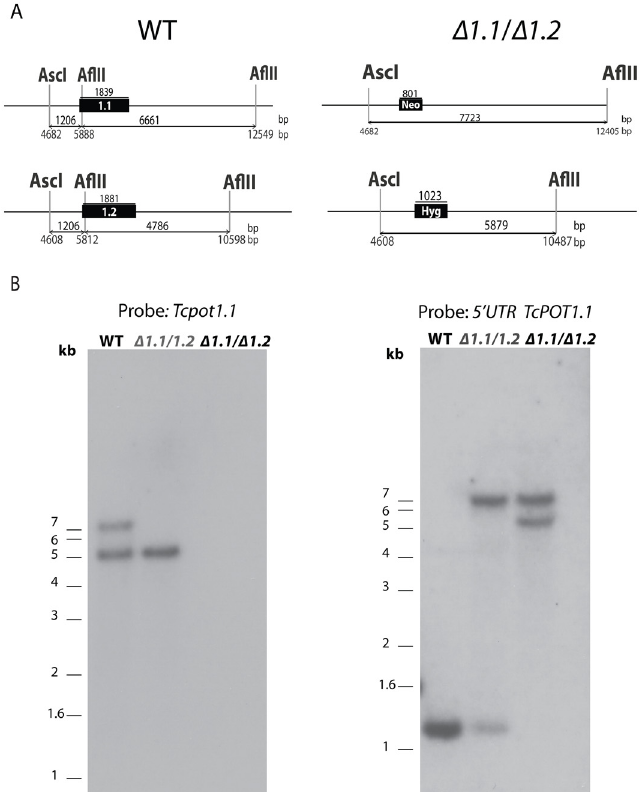
Fig 1. Gene targeting constructs and Southern blot analysis of T . cruzi CL Brener genomic DNA from wild type and transgenic T . cruzi . (A) Diagram of the TcPOT1 . 1 (1.1) and TcPOT1 . 2 (1.2) loci in wild type (WT) T . cruzi (left panel) and in the Δ tcpot1 ( Δ 1 . 1/ Δ 1 . 2 ) null mutant after the recombination events and integration of the G418 and hygromycin drug resistance cassettes, respectively (right panel). The positions of the AflII and AscI restriction sites that are germane to the Southern blot analysis are depicted with the relevant base pair (bp) distances between them shown below the locus depiction. (B) Southern blot analysis of wild type (WT), tcpot1 . 1 / TcPOT1 . 2 ( Δ 1 . 1/1 . 2 ) and Δ tcpot1 ( Δ 1 . 1/ Δ 1 . 2 ) cell lines digested with AflII and AscI. The blot was probed with the TcPOT1 . 1 open reading frame (left panel) or the TcPOT1 . 1 5 ’ -untranslated region (right panel).